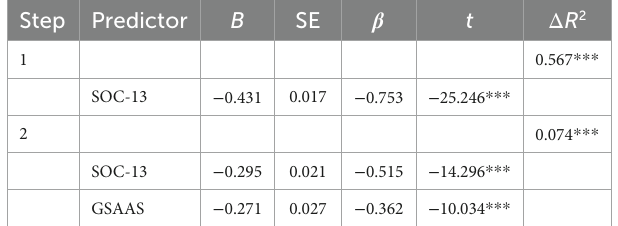
TABLE 6 Hierarchical regression analysis: the GSAAS as predictor of SD (OQ-45) beyond SOC